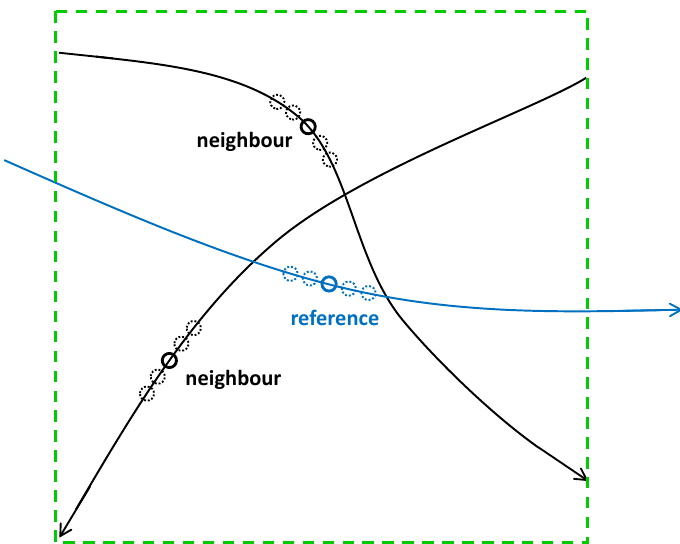
Figure 9. Example of local trajectory interaction at a given